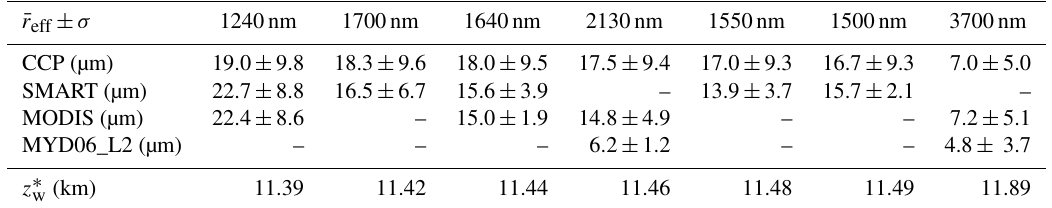
Table 4. The mean standard deviation of r eff from in situ (CCP), retrievals (SMART and MODIS), and MODIS cloud product (MYD06_L2) for different near-infrared wavelengths between 1240 and 3700nm. The wavelengths have been sorted so that the degree of absorption by cloud particles increases to the right. The last line is the weighting altitude z ∗ w